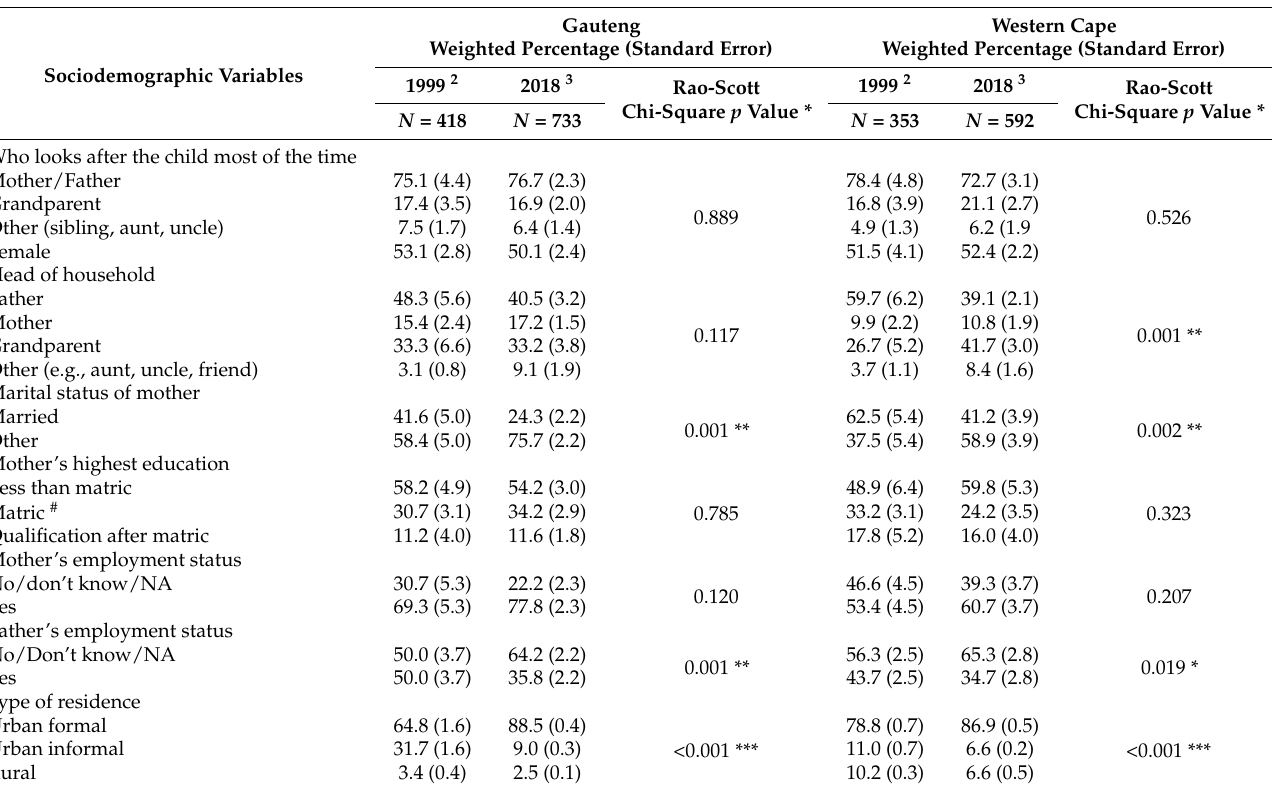
Table 1. Socio-demographic profiles 1 of 1–<10-year-old children in Gauteng and Western Cape, in 1999 and 2018 and relationships with timepoint within provinces and between provinces at a particular